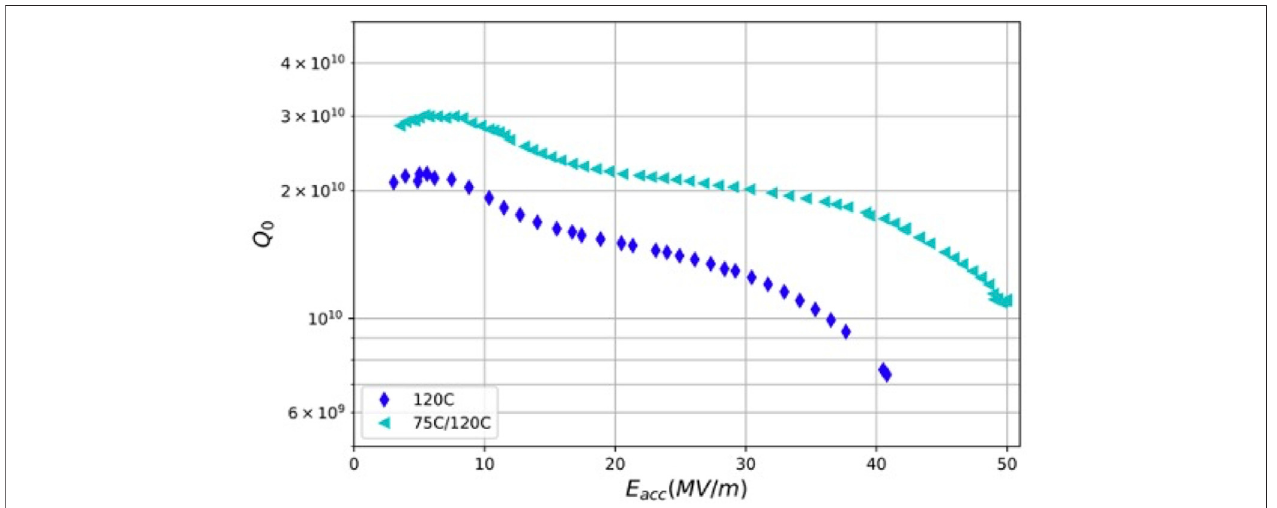
FIGURE 3 | Q vs. E curve of single-cell cavity reaching 49 MV/m from cold EP/optimized baking (75/120 ° C) compared to the curve of a cavity prepared by the standard ILC